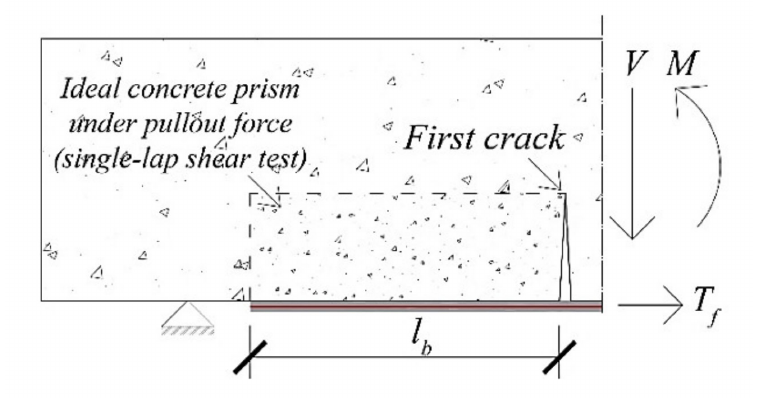
Figure 4. Anchorage strength